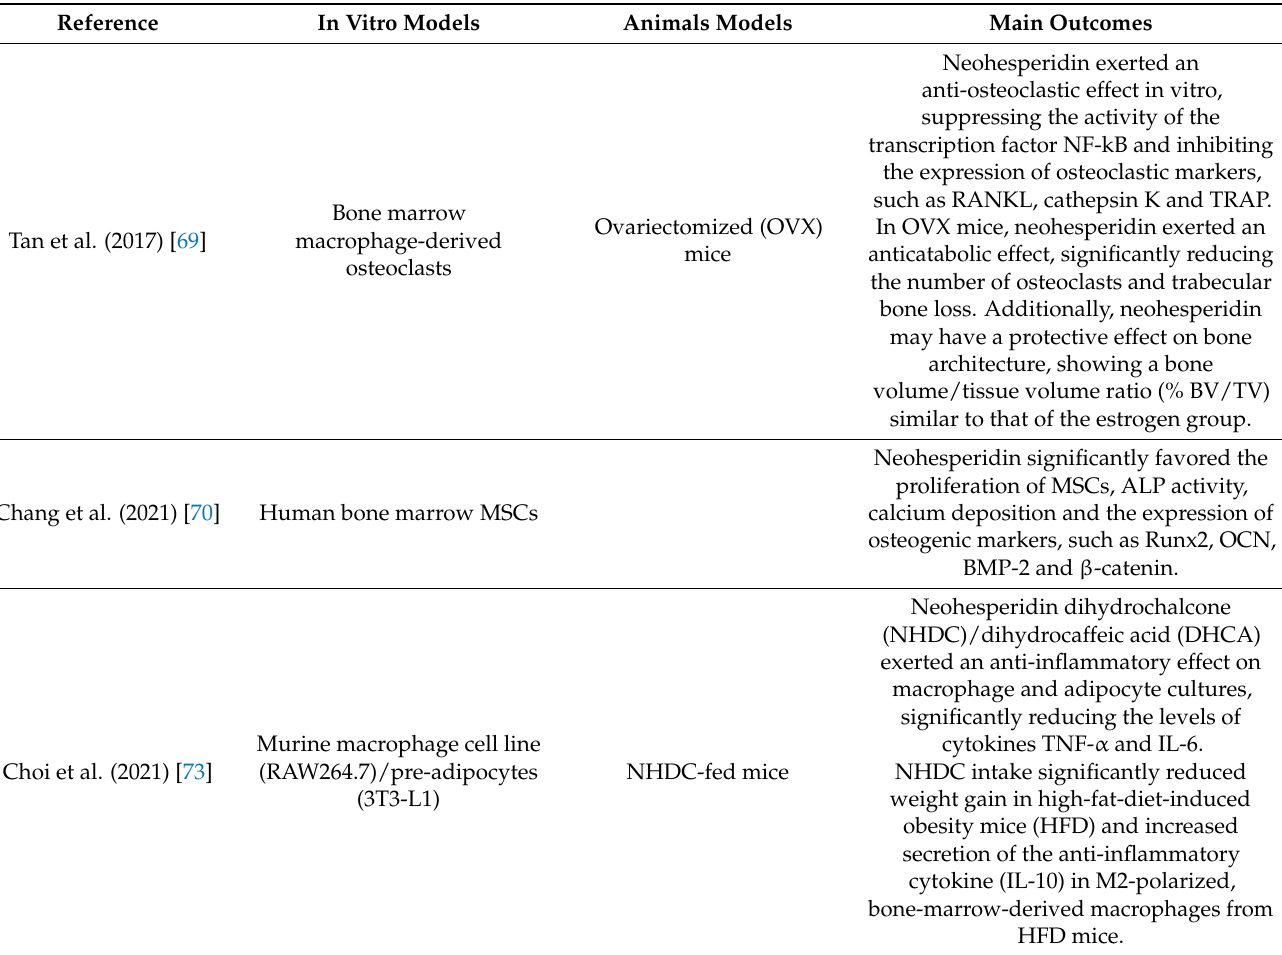
Table 1. In vitro and in vivo studies that evaluated the osteoprotective and anti-inflammatory effects of neohesperidin or neohesperidin dihydrochalcone (NHDC)/dihydrocaffeic acid